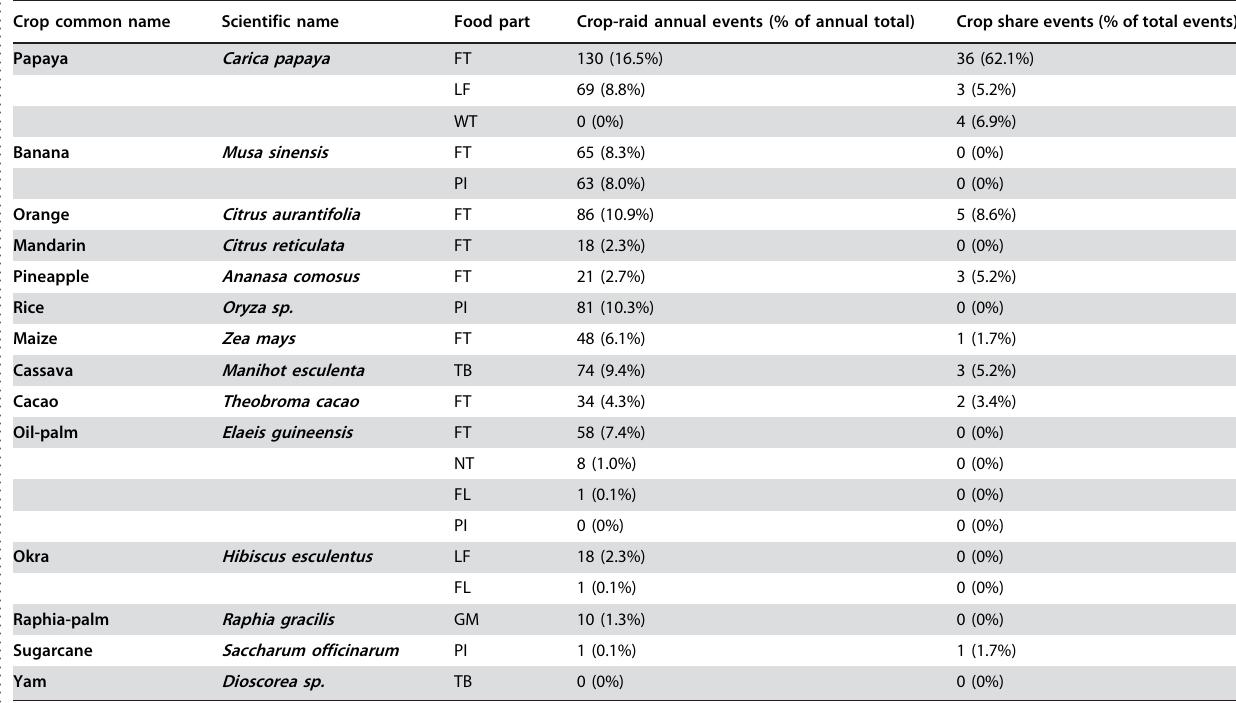
Table 1. Shows the frequencies (and percentages) of crop-raiding and crop sharing by the chimpanzees of Bossou. .. ... .... ... ... .... ... ... .... ... ... .... ... ... .... ... ... .... ... ... .... ... ... .... ... ... .... ... ... .... ... ... .... ... ... .... ... ... .... ... ... .... ... ... . Crop common